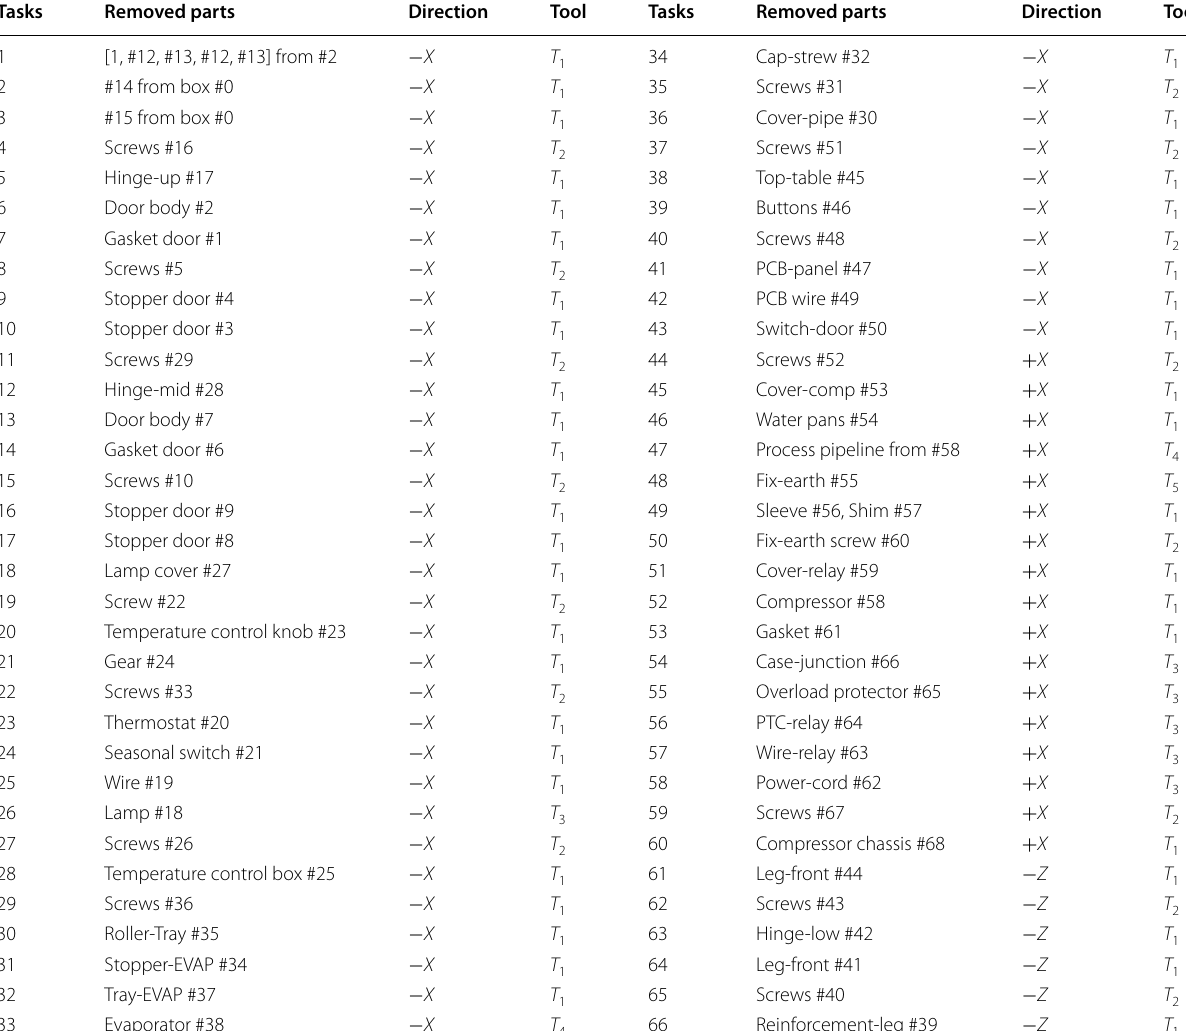
Table 5 The tasks for disassembly data of the refrigerator Tasks